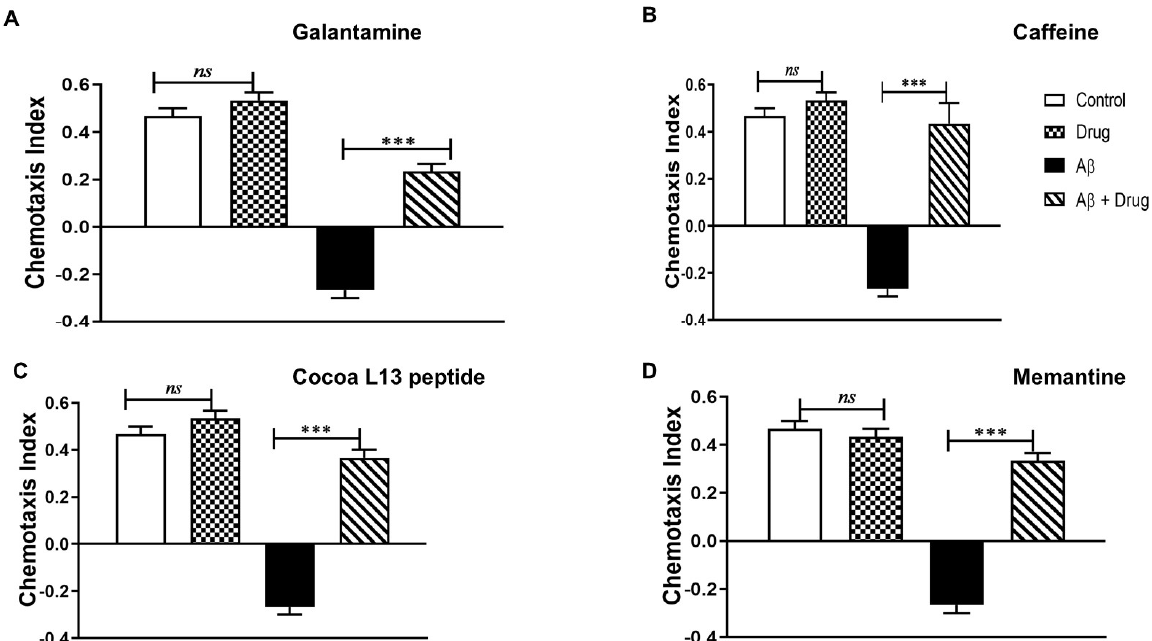
Figure 5. Neuroprotective agents ameliorate A β (1–42)-induced impairment of chemosensing. Two clinically used drugs (galantamine and memantine) and two neuroprotective agents (caffeine and 13L cocoa peptide, previously observed to be beneficial in A β -expressing C. elegans ) were selected and assessed for their ability to ameliorate the effects of A β (1–42) in G. pallida . G. pallida second-stage juveniles (J2s) were pre-incubated (24 h) with either (1) the vehicle control (1% DMSO in ddH 2 O), (2) A β (1–42), (3) the tested drug alone, or 4) A β (1–42) in combination with the tested drug: ( A ) galantamine (100 µM); ( B ) caffeine (3.6 mM); ( C ) 13L cocoa peptide (200 µg/mL); ( D ) memantine (10 mM). When tested alone, none of these agents affected the chemotaxis index (CI). All ameliorated A β (1–42)-induced impairments in the CI ( p < 0.001). The data are mean ± SEM ( n = 3) with approximately 100 G. pallida organisms per observation. ns (not significant), *** p < 0.001 compared to either the vehicle control or the A β (1–42) group.